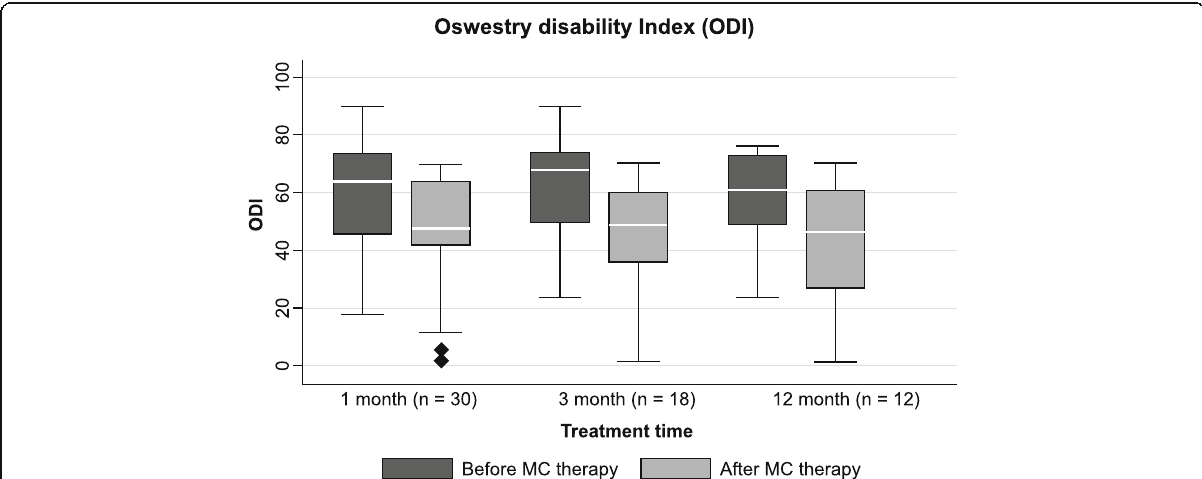
Fig. 4 Oswestry Disability Index at 1, 3, and 12 months. ODI boxplots before and after MC therapy at 1, 3, and 12 months. Statistically significant improvements were registered for comparisons at 1, 3, and 12 months ( P < 0.01). The boxes contain the middle 50% of the values; the thick white lines indicate the median; the whiskers connected by dashed lines to the boxes mark the minimum and maximum values except when there are outliners, which are specifically indicated by circles. ODI Oswestry Disability Index, MC medical cannabis